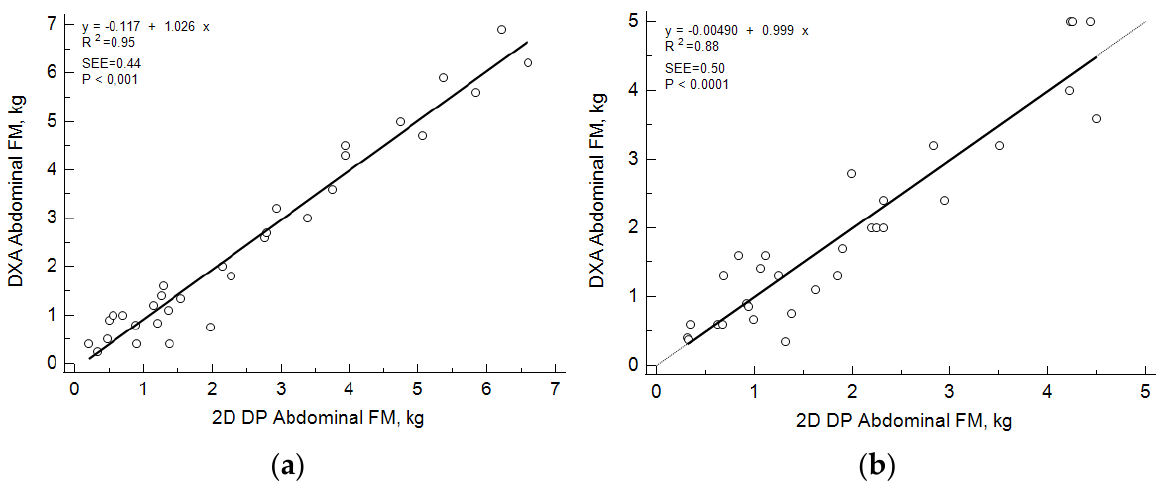
Figure 5. Linear regression plots of dual x-ray (DXA)-measured and two-dimensional digital imaging photography (DP)-estimated abdominal (L2 – 5) fat mass values in females ( a ) and males ( b ).